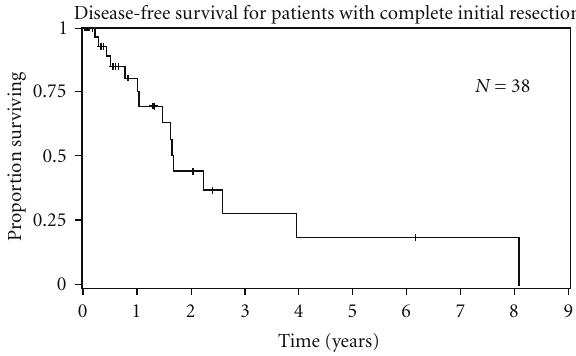
Figure 3: Disease-free survival of 38 patients who underwent complete initial resection of the primary retroperitoneal tumor.